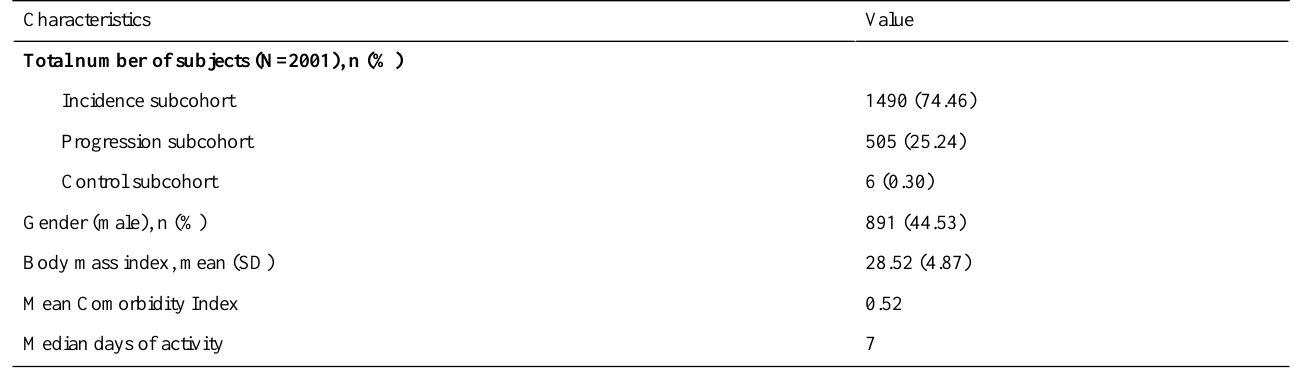
Table 1. Key attributes of the knee osteoarthritis subjects providing physical activity data.